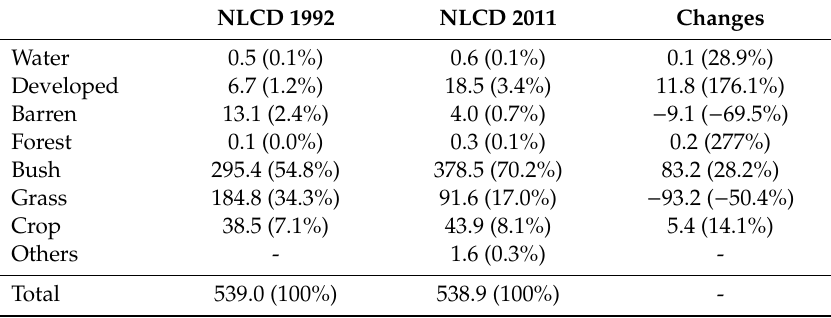
Table 6. The area for each land-cover type in the study area (unit: km 2 ).